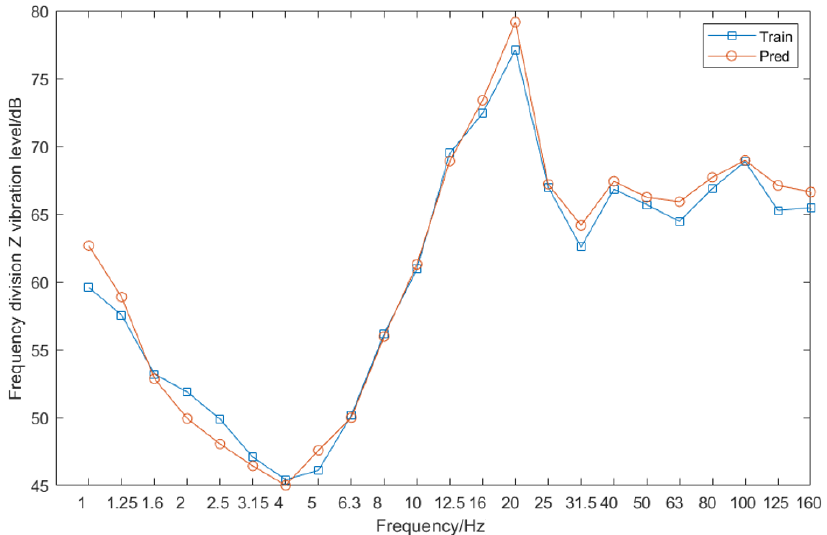
Figure 23. Vibration acceleration after inverse Fourier transform from Channel 7.